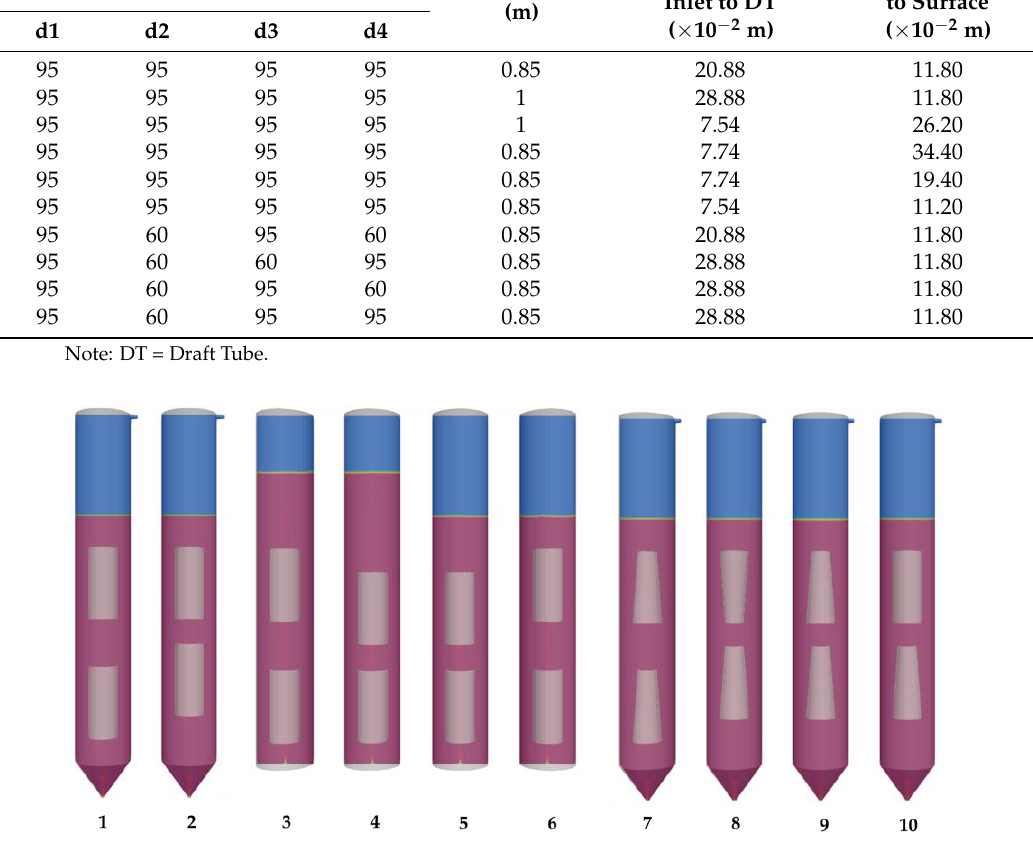
Table 1. Geometry internal parameters .